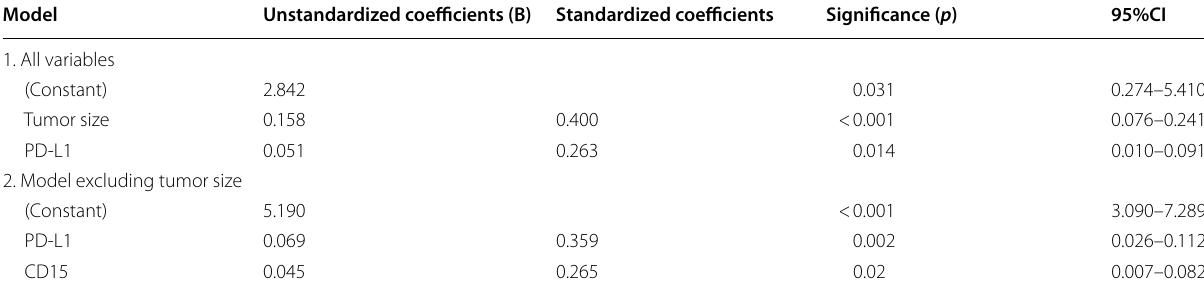
Table 3 Results of multiple regression analysis for FDG PET